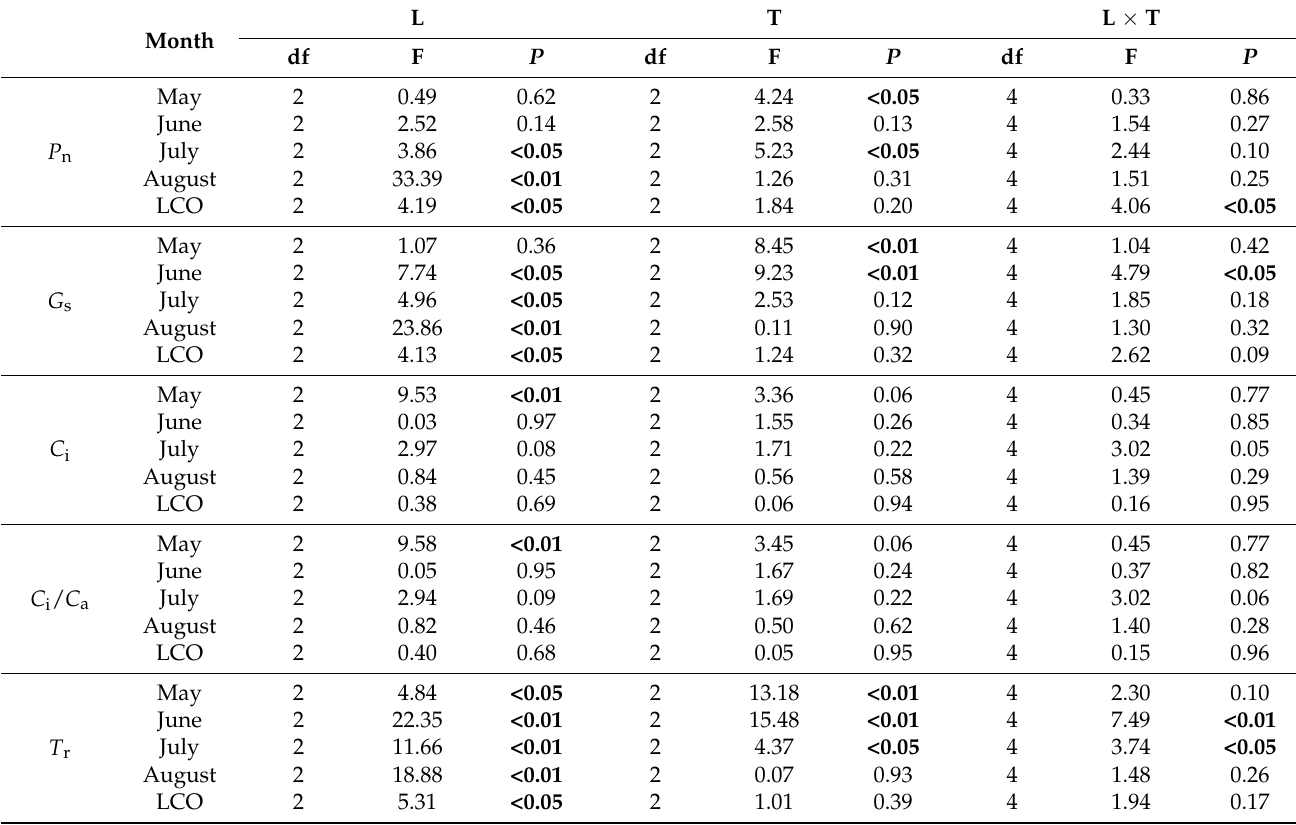
Table 2. Effects of photoperiod (L), temperature (T), and their interaction on leaf gas exchange parameters of Quercus mongolicus